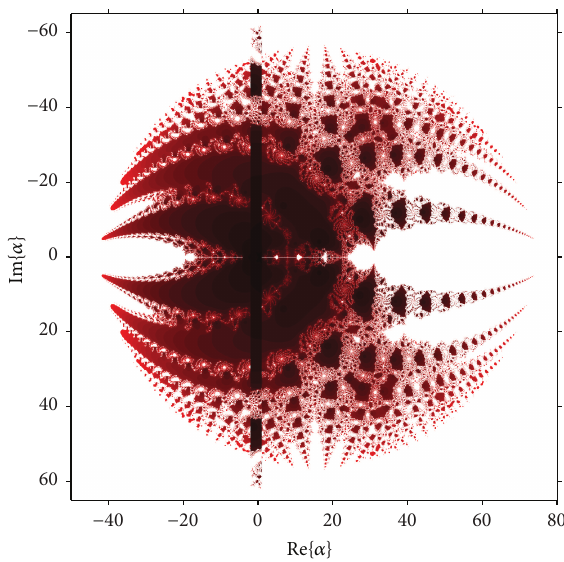
Figure 1: Parameter plane 𝑃 1 associated with 𝑧 = cr 𝑖 , 𝑖 = 1, 2